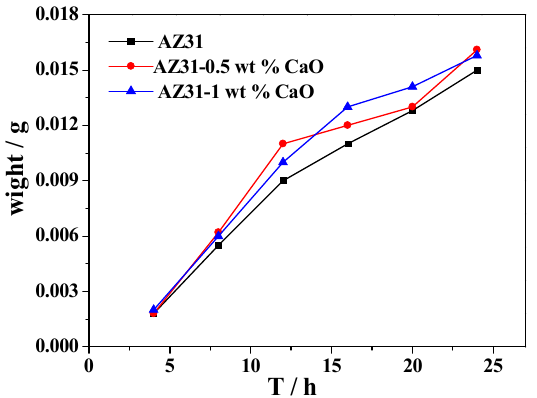
Figure 10. Electrochemical impedance spectra of extruded AZ31-xCaO alloys.